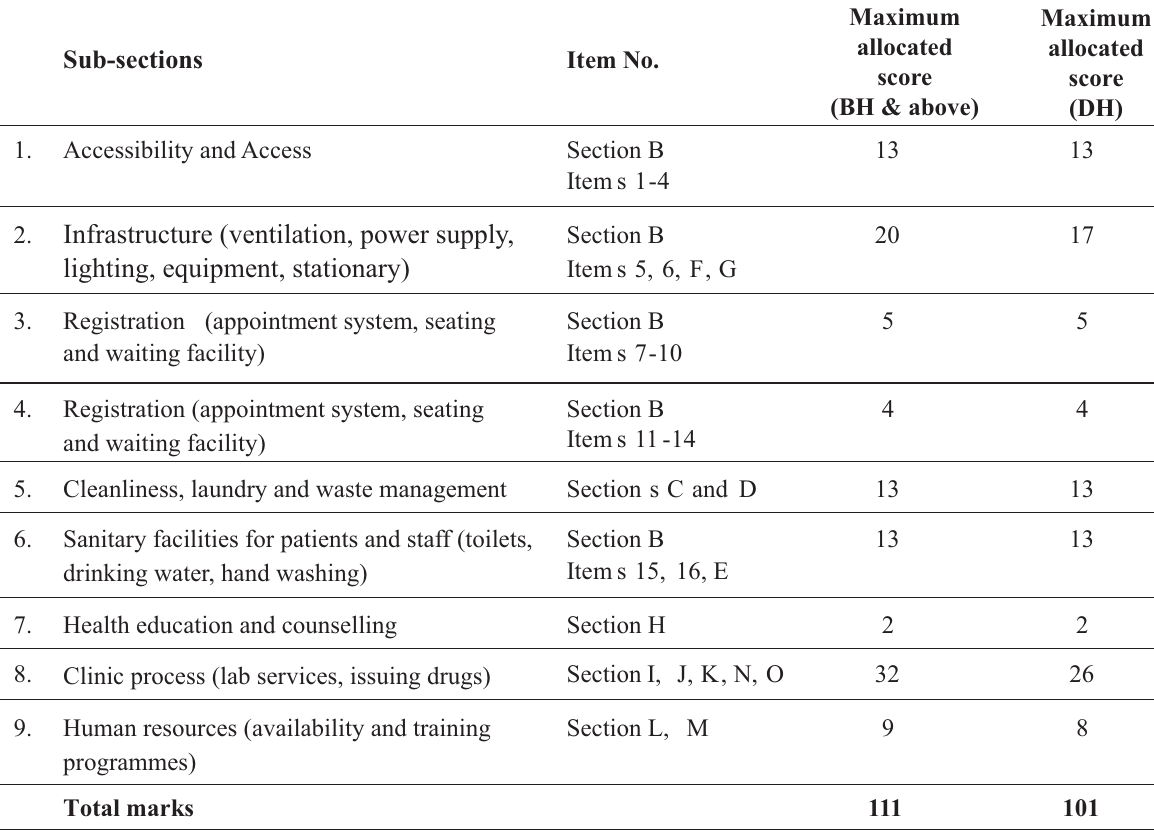
Table 1: Sub-sections and maximum allocated scores in assessment of health care service provision in the leprosy